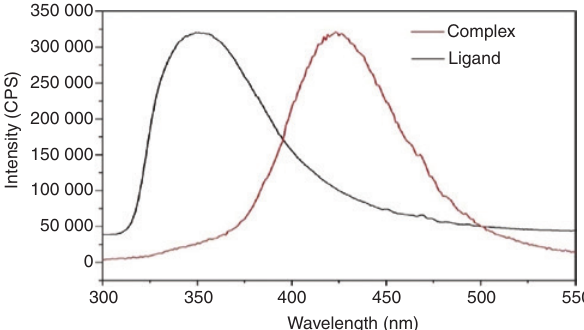
Figure 10: The solid state photoluminescent spectra of phthalic acid and